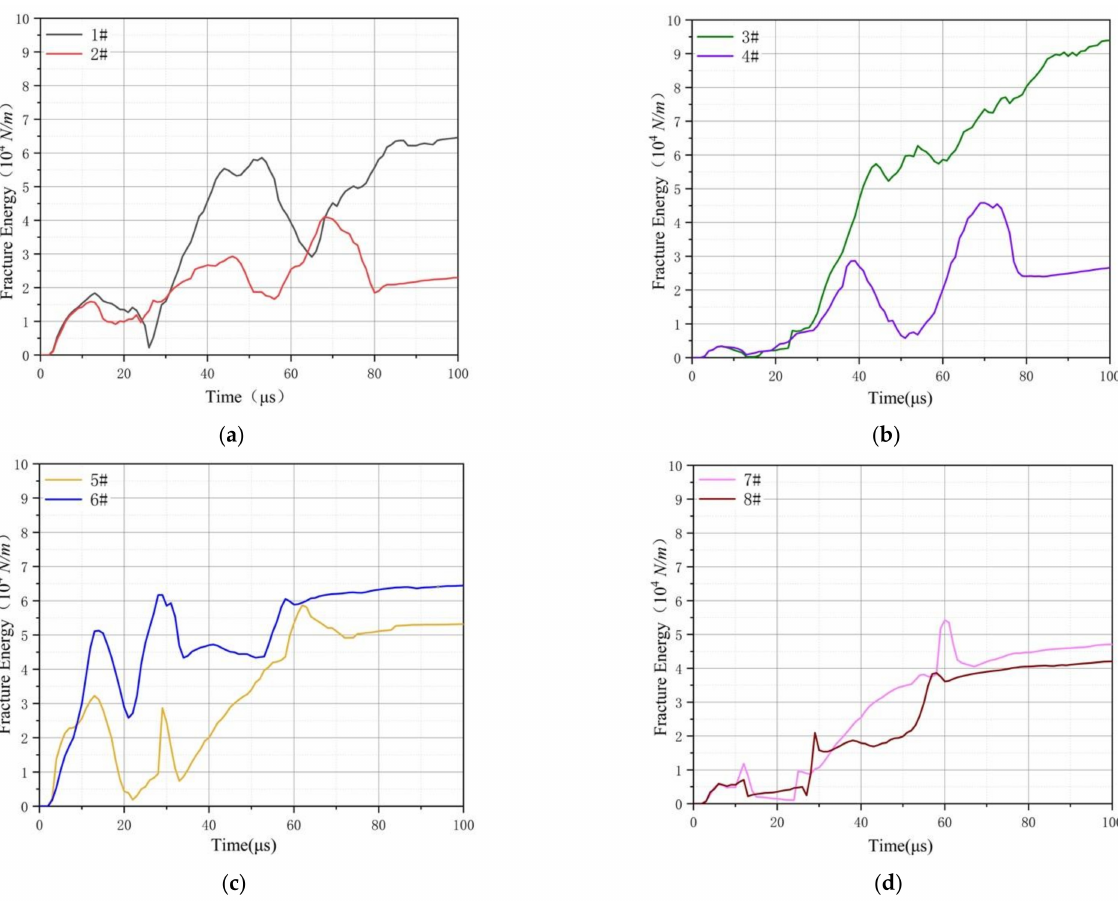
Figure 9. Fracture energy curves of 1#–8# composite structures. ( a ) Fracture energy curves of 1# and 2# composite structures; ( b ) Fracture energy curves of 3# and 4# composite structures; ( c ) Fracture energy curves of 5# and 6# composite structures; ( d ) Fracture energy curves of 7# and 8# composite